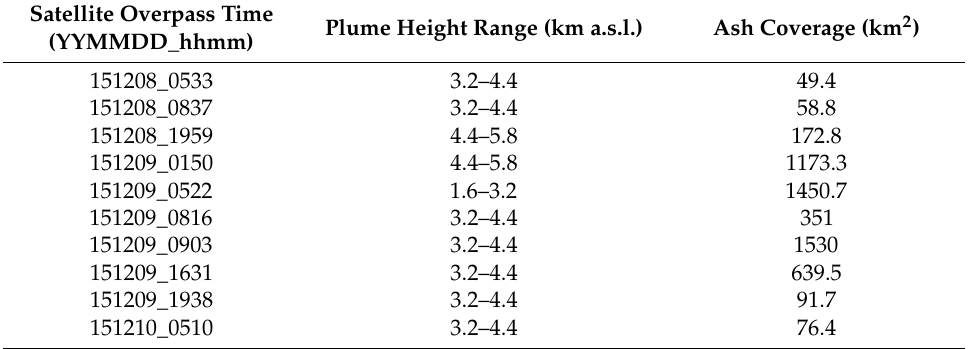
Table 1. Satellite overpass times, range of plume height (i.e., min and max value for each analyzed satellite scene) and ash coverage retrieved starting from RST ASH detections of 8–10 December 2015. Satellite Overpass Time Plume Height Range (km a.s.l.) Ash Coverage (km 2 ) (YYMMDD_hhmm)